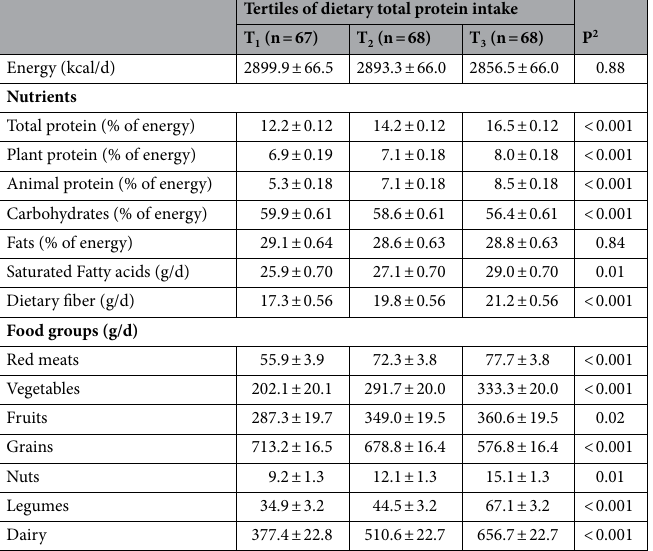
Table 2. Multivariable-adjusted intakes of selected food groups and nutrients of study participants across tertiles of dietary total protein intake (n = 203) 1 . 1 All values are means ± standard error (SE); energy and macronutrients intake were adjusted for age and gender; all other values and saturated fatty acids are adjusted for age, gender and energy intake. 2 Obtained from ANCOVA.